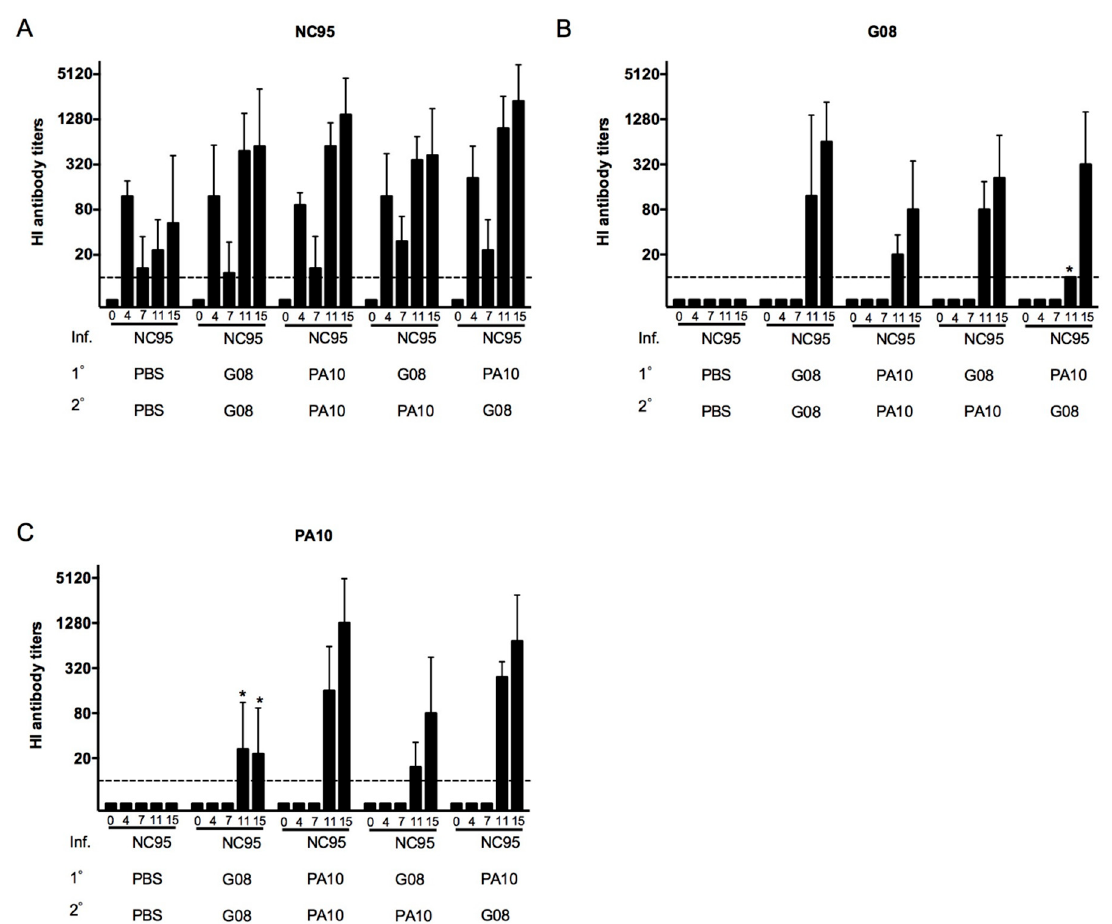
Figure 1. Evolution of hemagglutination inhibition (HI) antibody titers against the strains used for infection, ( A ) NC95, and vaccination, ( B ) G08 and ( C ) PA10. The titers were determined at weeks 0, 4, 7, 11, and 15 following infection with NC95. The interval between infection (Inf.) and the first vaccination (1°) was 7 weeks. The second vaccination (2°) was administered 4 weeks later. The different groups are shown on the x-axis. The dotted lines indicate the detection limit, which in this case was a titer of 10. Asterisks denote statistical differences between groups that received heterologous (NC95-PA10-G08) and homologous (NC95-G08-G08) vaccines in Mann–Whitney U test ( p < 0.05).